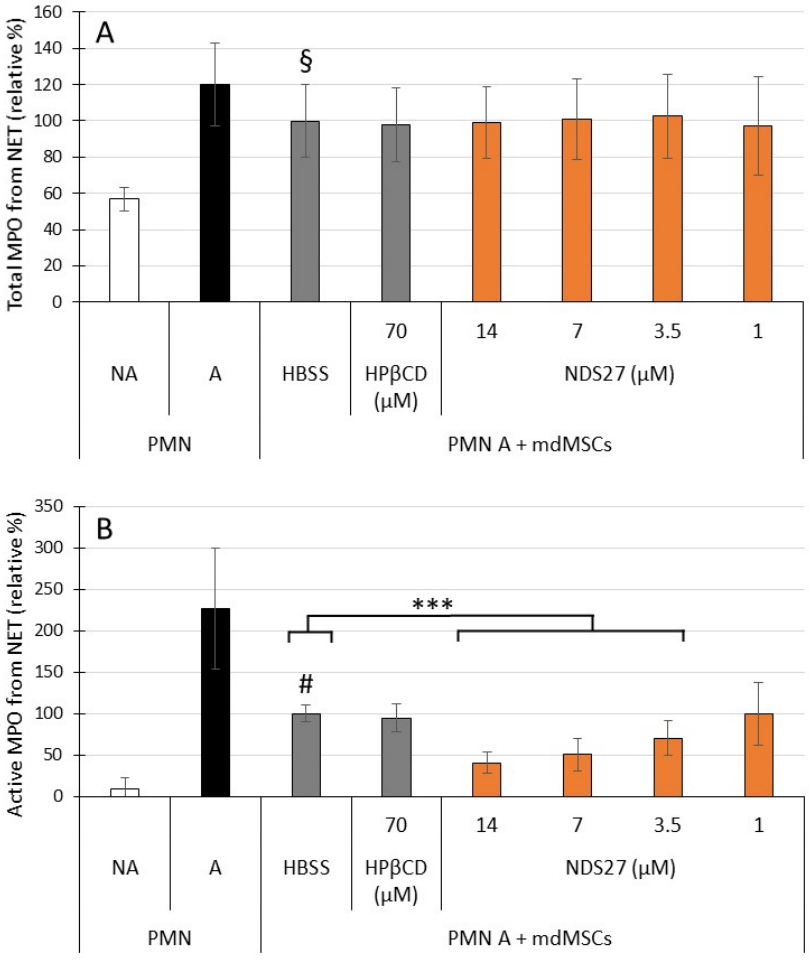
Figure 4. Effect of non-activated (PMN NA) and CB + fMLP activated neutrophils (PMN A) alone or mixed with non-loaded (HBSS) and loaded mdMSCs with HP β CD (70 µM) or NDS27 (1, 3.5, 7, 14 µM) on total ( A ); and active ( B ) MPO bound to the NET. The numbers of neutrophil and MSCs per 2 mL medium were 1 × 10 6 and 0.5 × 10 6 respectively. Means ± SD are shown in relative percentages versus non-loaded cells (HBSS) in the presence of stimulated neutrophils defined as 100% response. Statistical analysis was considered for 5 independent experiments (2 technical replicates) with MSCs from 3 horses. *** p < 0.001 vs. HBSS, # p < 0.001 vs. PMN A, § p < 0.01 vs. PMN A.